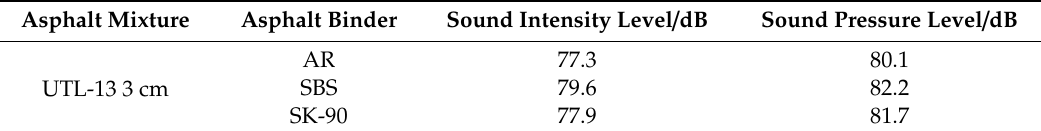
Table 5. Noise test results of UTL with di ff erent kinds of asphalt binder.